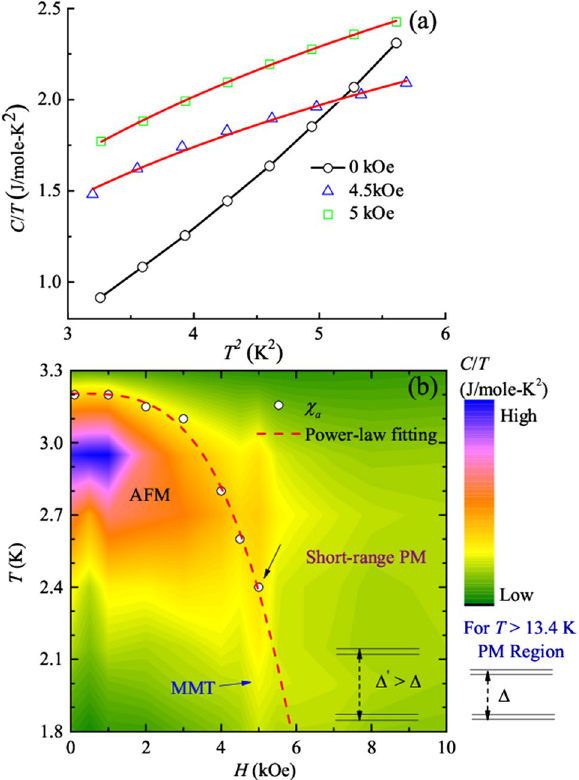
Figure 6. ( a ) C / T vs T 2 curves obtained at 0 kOe, 4.5 kOe and 5 kOe. Solid red lines show the power-law fitting to the data. ( b ) Magnetic phase diagram for DyVO 4 presented as an H – T color map plot with C / T represented as the color scale. The red solid line corresponds to the power-law dependence of T N . The black arrow shows the position of